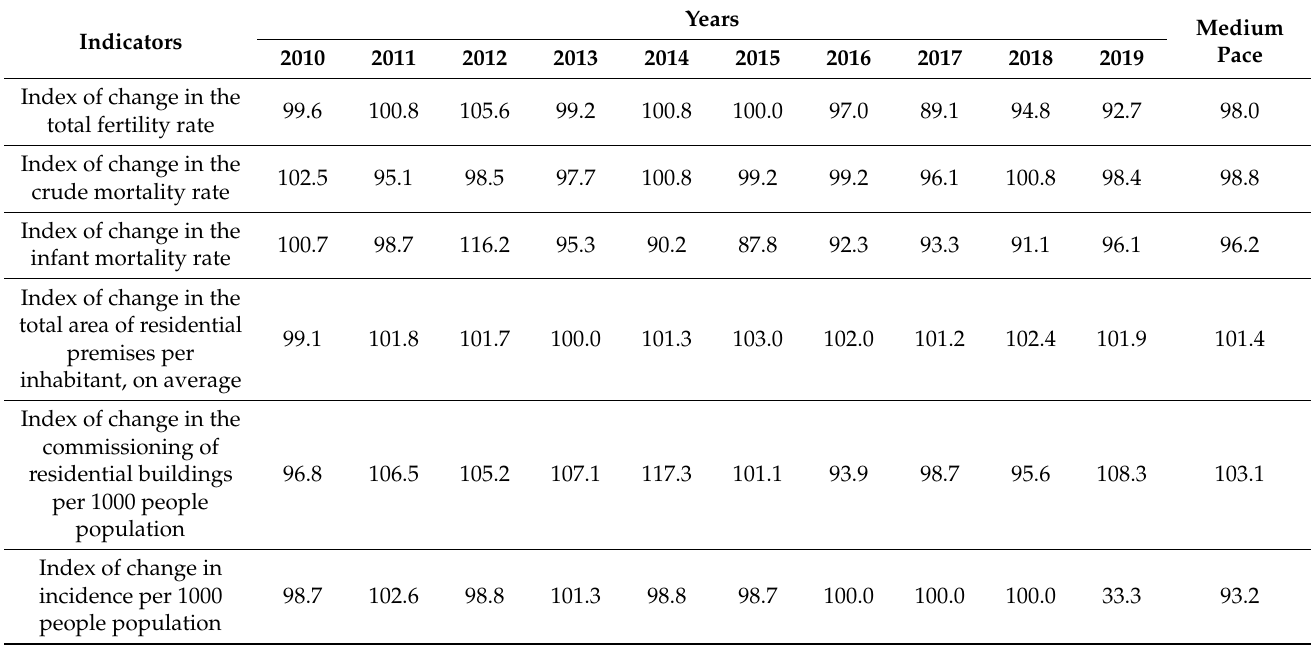
Table 10. Dynamics of changes in indicators characterizing the macro-regional block “Society” in